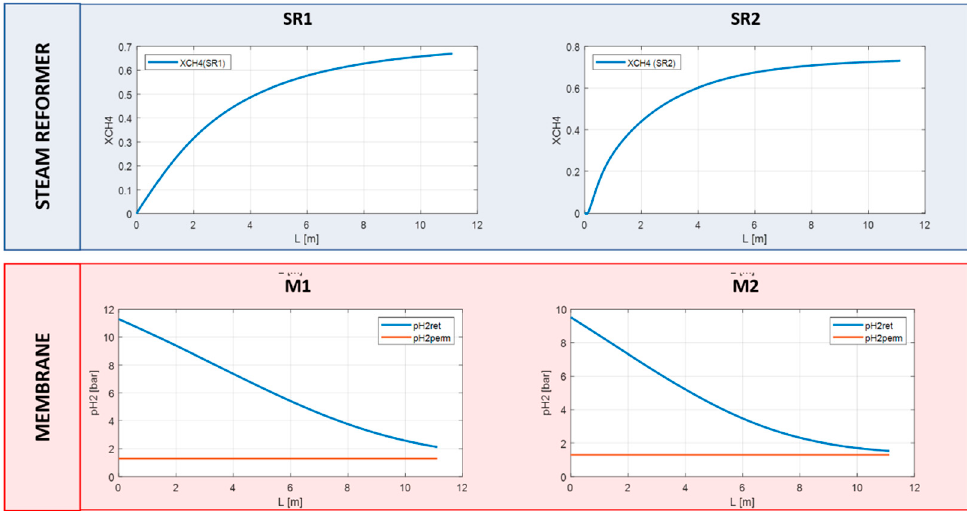
Figure 8. Methane conversion and hydrogen partial pressure in RMM scheme.